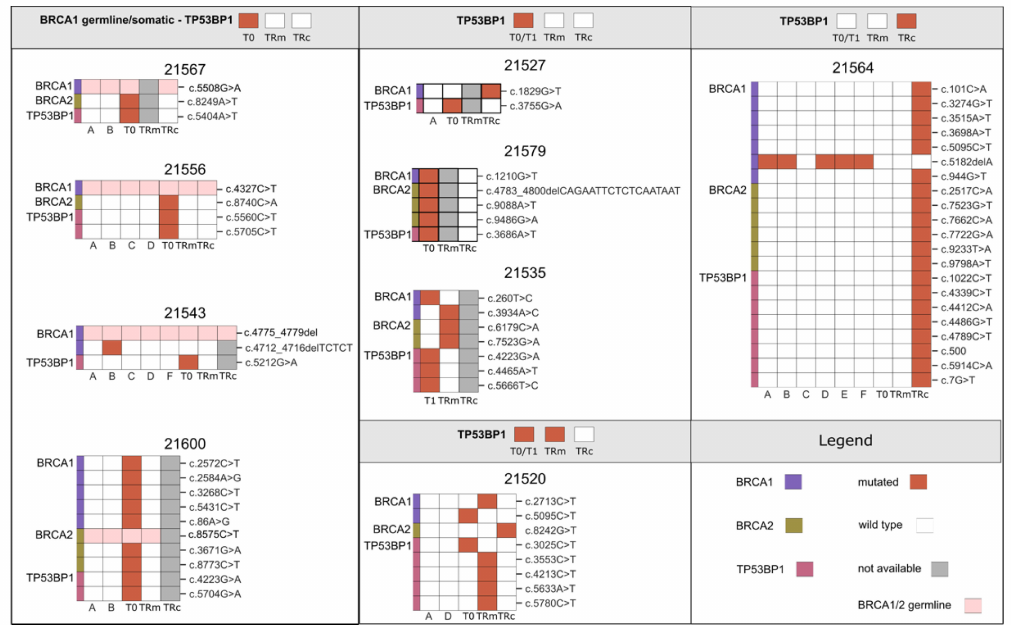
Figure 5. Oncoprints of 13 patients carrying pathogenic mutations in the TP53BP1 gene. For each oncoprint, mutated genes, e.g., BRCA1/2 or TP53BP1 , are reported on the left; codon change is reported on the right; the patient number is reported on the top, and the name of each sample at the bottom. Colors as reported in the